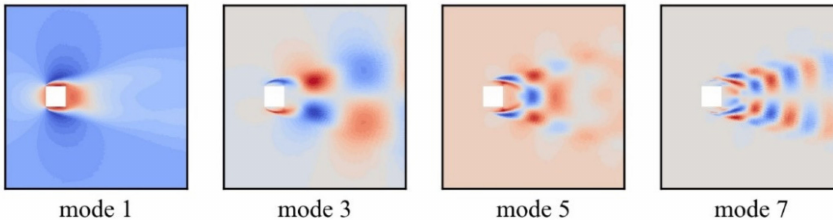
Figure 7. Dominant POD modes of the single square cylinder fields.